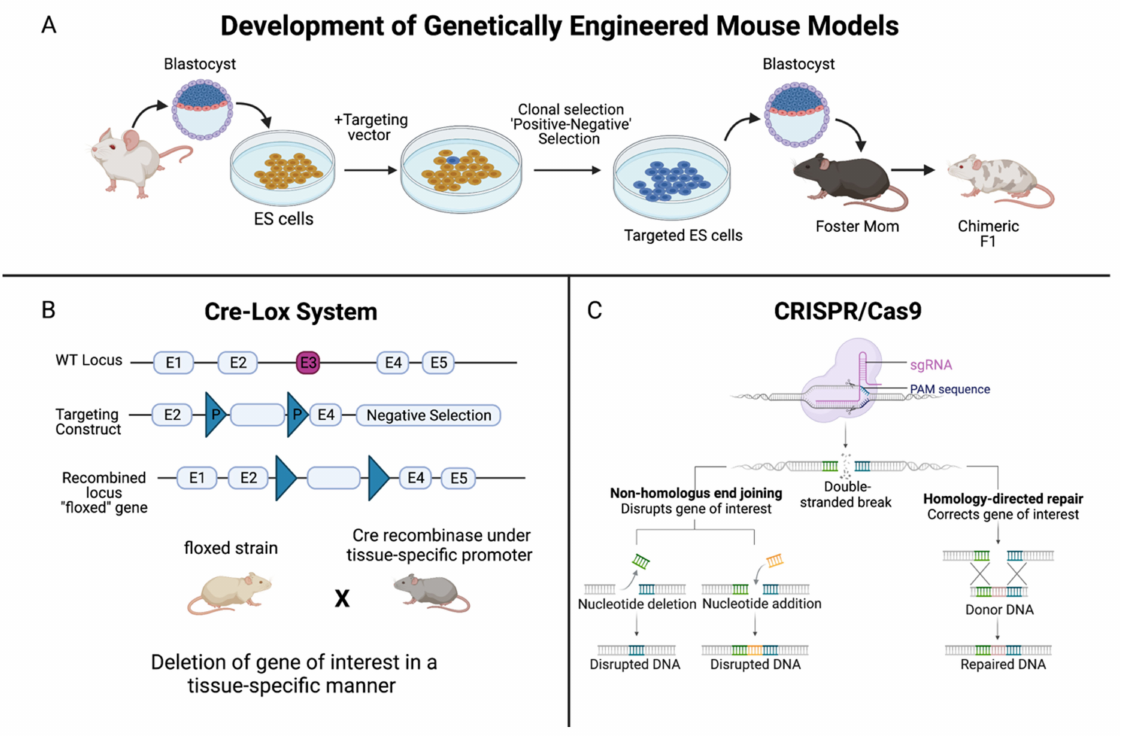
Figure 1. Summary of the development of genetically-engineered mouse models. ( A ) Genetically- engineered (GE) mice are used extensively in research as models of human disease. In the context of cancer, by deleting, or “knocking out”, the function of a specific gene, one can determine the significance of that gene in either promoting or halting the progression of tumor development.